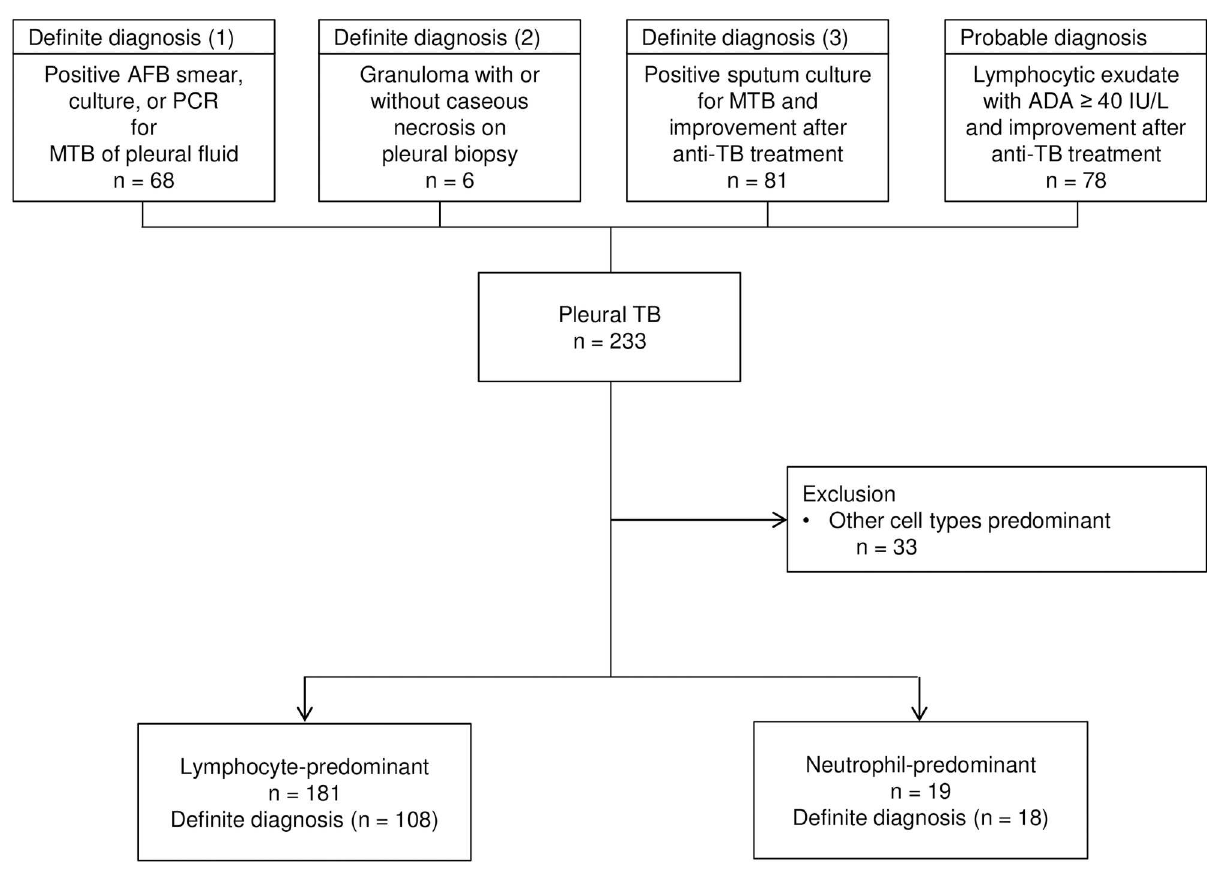
Fig 1. Groupings of study population according to diagnostic criteria and cell type predominance. TB, tuberculosis; AFB, acid-fast bacilli; PCR, polymerase chain reaction; MTB, Mycobacterium tuberculosis ; ADA, adenosinedeaminase.